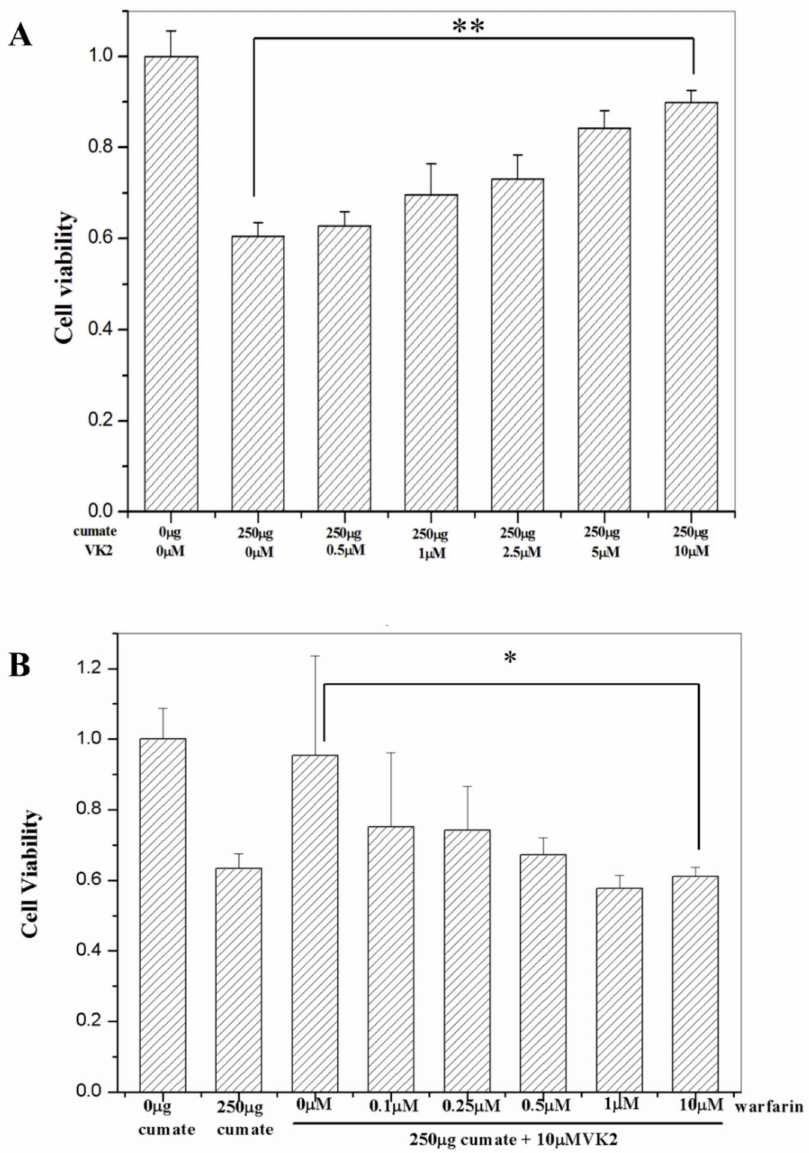
Figure 1. Cell viability determined by MTT assay. ( A ) Percentage survival of β -CTF/C6 cells incubated with 250 µ g cumate and various vitamin K2 (VK2) concentrations for 72 h. ( B ) Warfarin reduces cell viability in the presence of vitamin K2. Percentage survival of β -CTF/C6 cells incubated with 10 µ M vitamin K2 (VK2) and various warfarin concentrations for 72 h. Wells containing β -CTF/C6 cells without cumate were the control. Data are means ± SD. ** p < 0.01 and * p <